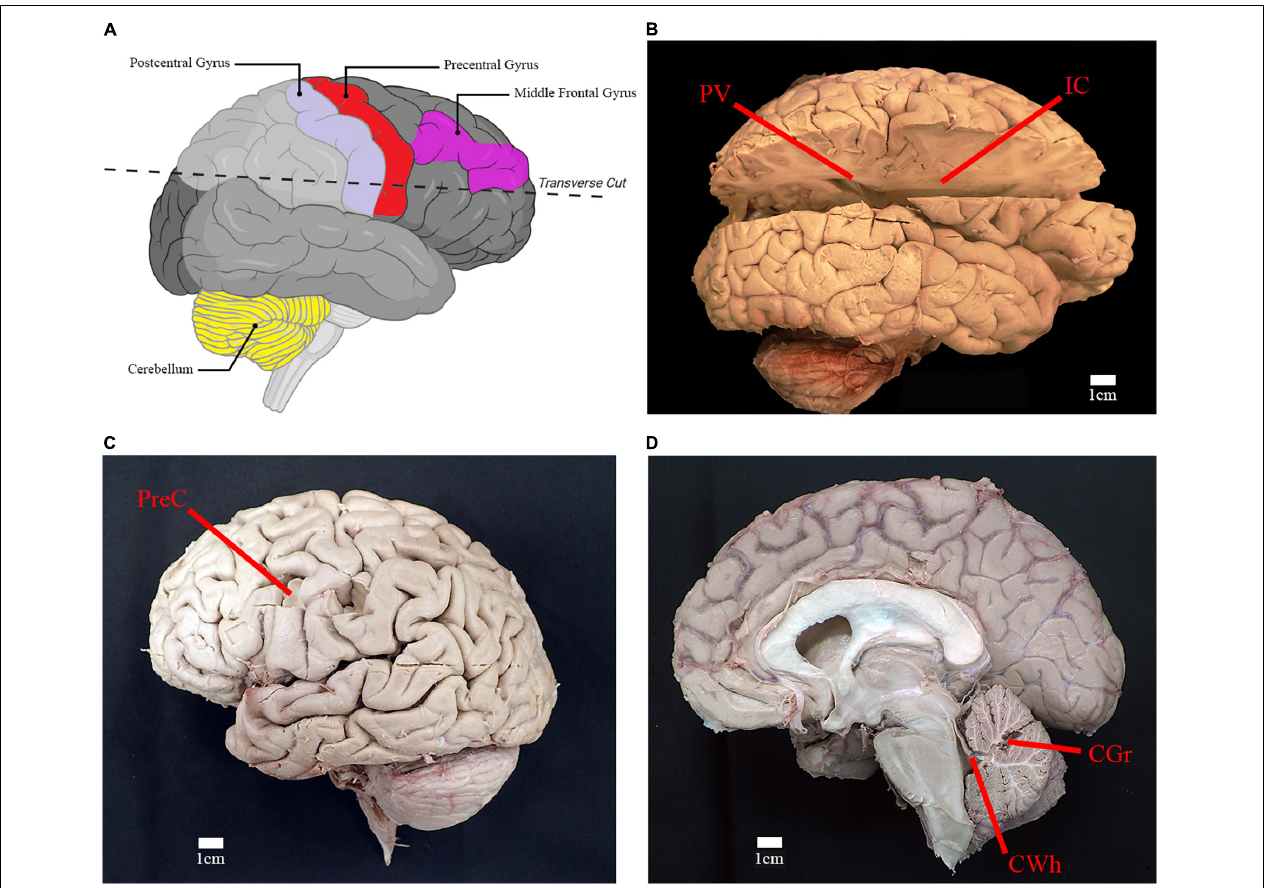
FIGURE 3 | Location of relevant anatomical structures and sites of sampling. (A) Illustration of right cerebral hemisphere and location of incision to access deep white matter structures (created using Biorender.com). (B) Lateral view of right cerebral hemisphere with incision from parietooccipital sulcus to frontal pole. Location of sampling for periventricular white matter (PV) and posterior limb of internal capsule (IC) are shown. (C) Lateral view of left cerebral hemisphere depicting the sampling location for gray matter and subcortical white matter of the precentral gyrus of the frontal lobe (PreC). (D) Midsagittal view of right cerebral and cerebellar hemispheres. Sampling location of cerebellar gray matter (CGr) and white matter of the superior cerebellar peduncle (CWh) are